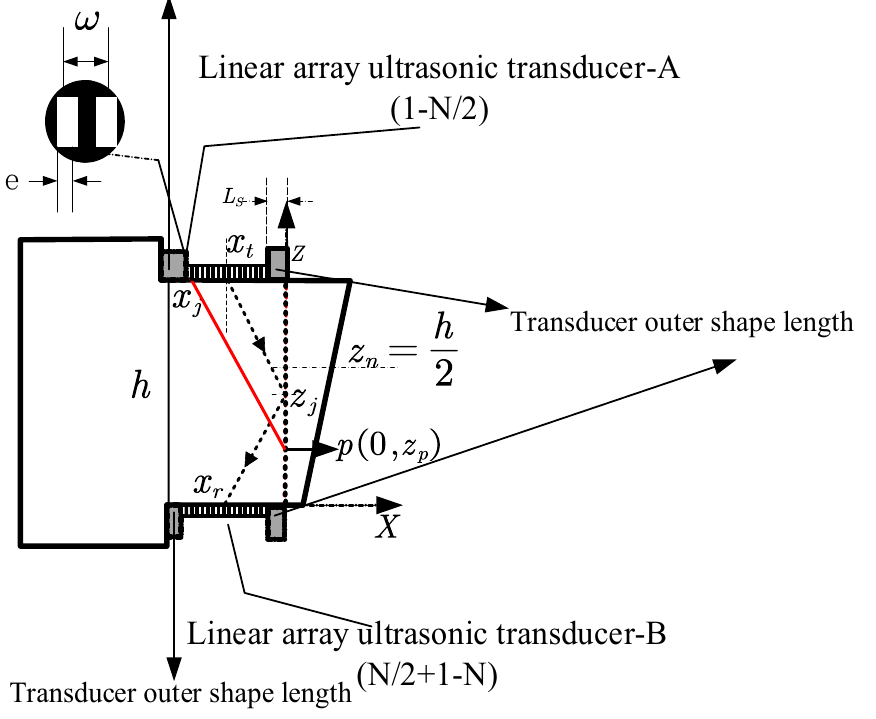
Figure 7. Delay time calculation of diffusion weld planar